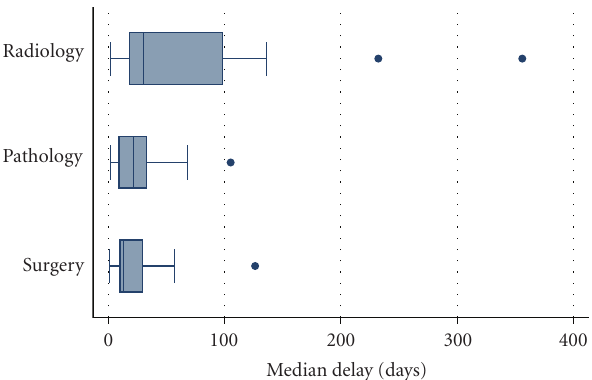
Figure 3: Box-plot demonstrating the radiology, pathology, and surgery lead times at the sarcoma centre. Outliers are marked by • .